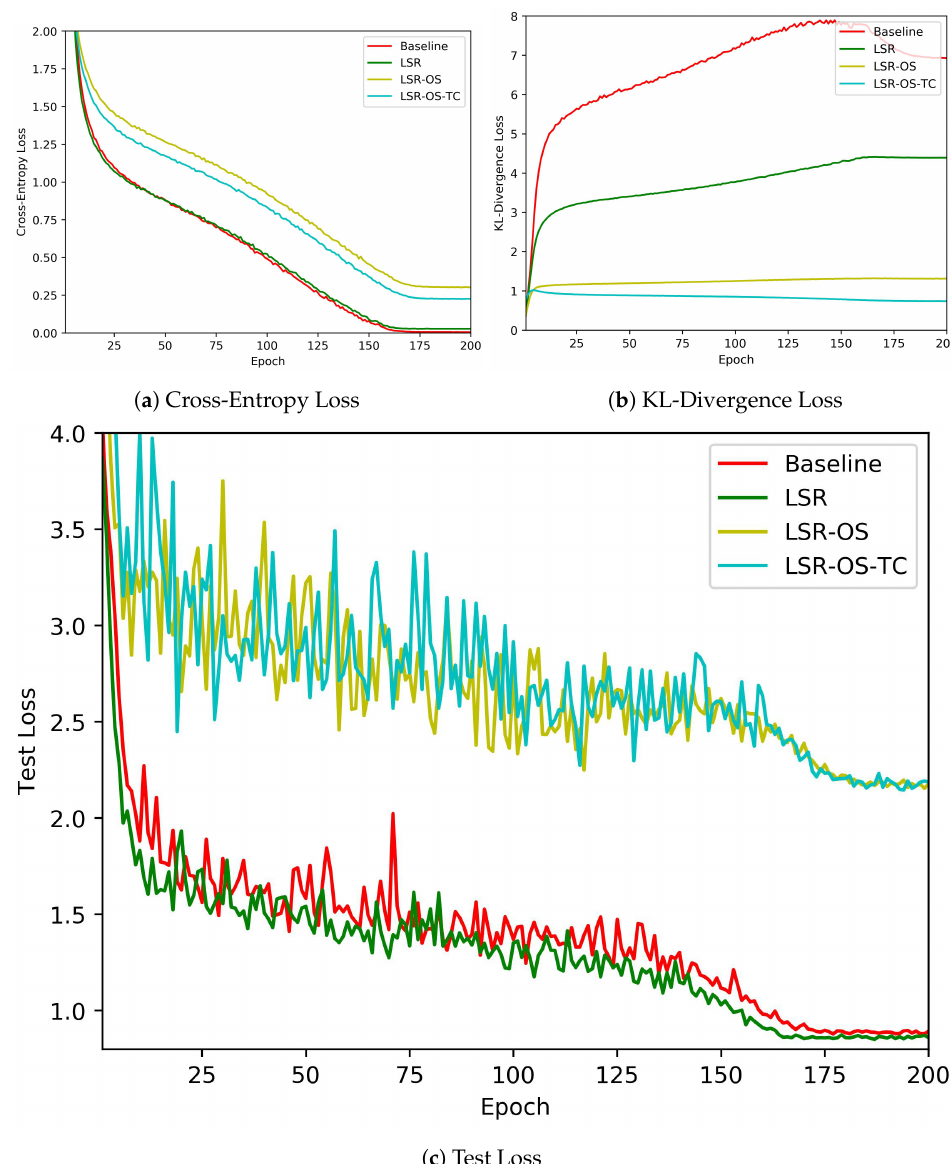
Figure 5. The loss curves for training on the CIRFAR100 dataset with the WRN-40-4